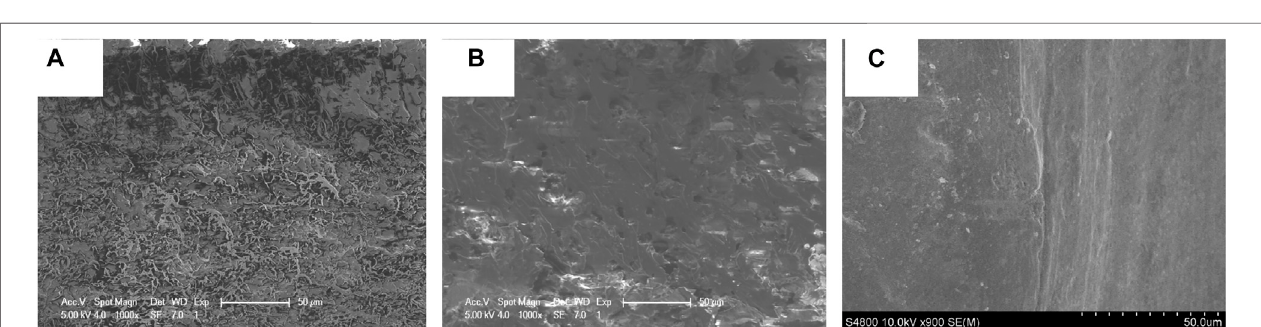
FIGURE 5 | The SEM cross-section images of prepared coatings, (A) pure EP, (B) PA/EP, and (C) PA/G/EP.